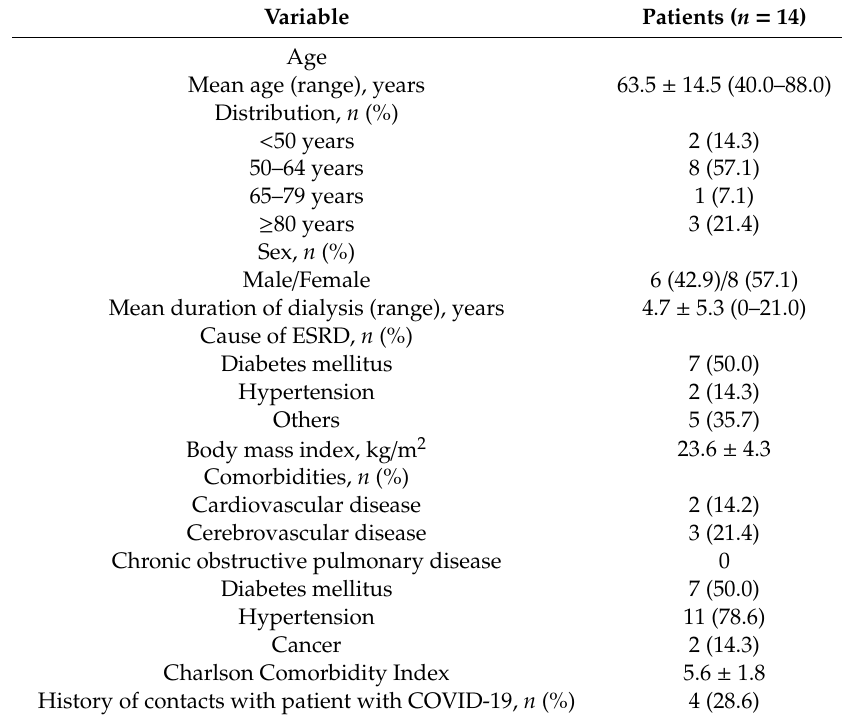
Table 1. Clinical